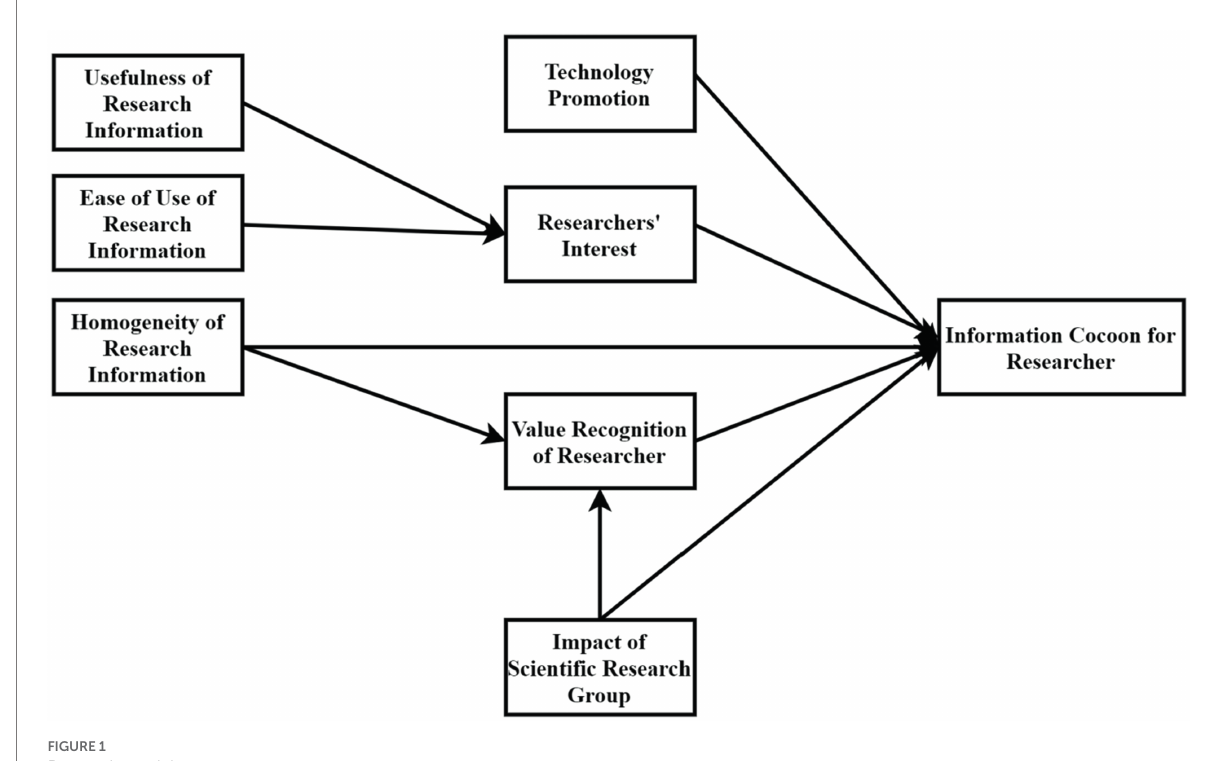
FIGURE 1 Research